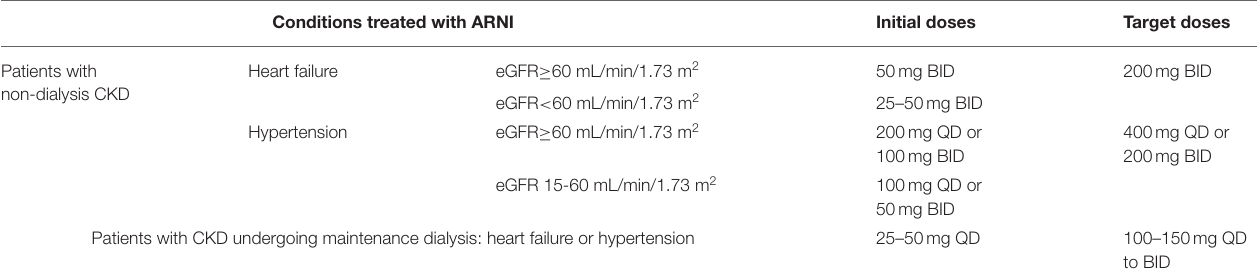
Conditions treated with ARNI